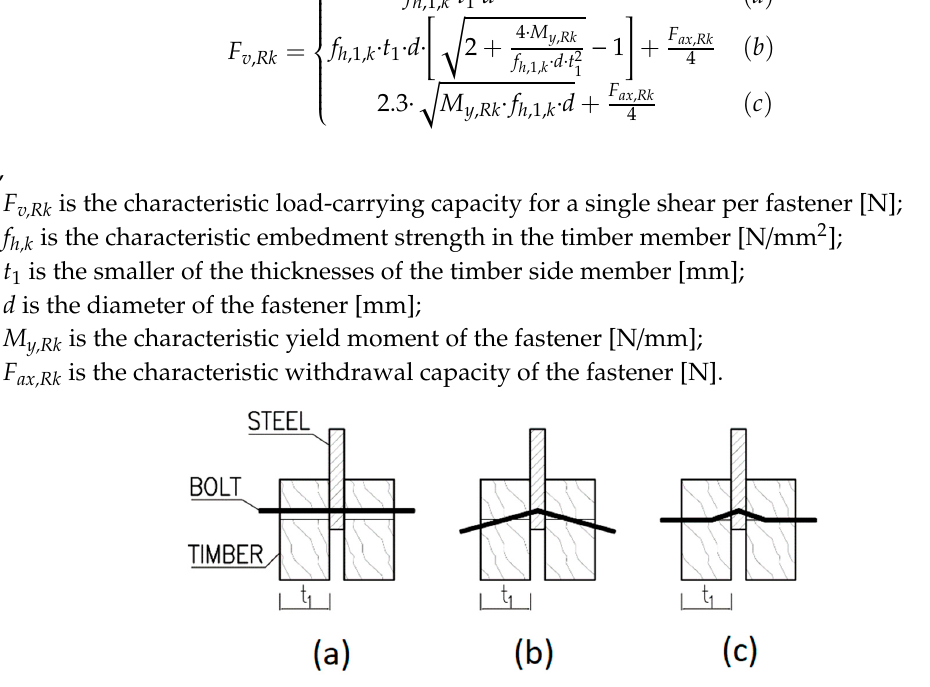
Figure 2. Failure modes for steel-to-timber connections: ( a ) Embedment of the timber; ( b ) Bending of the fastener; ( c ) Combination of both failures.